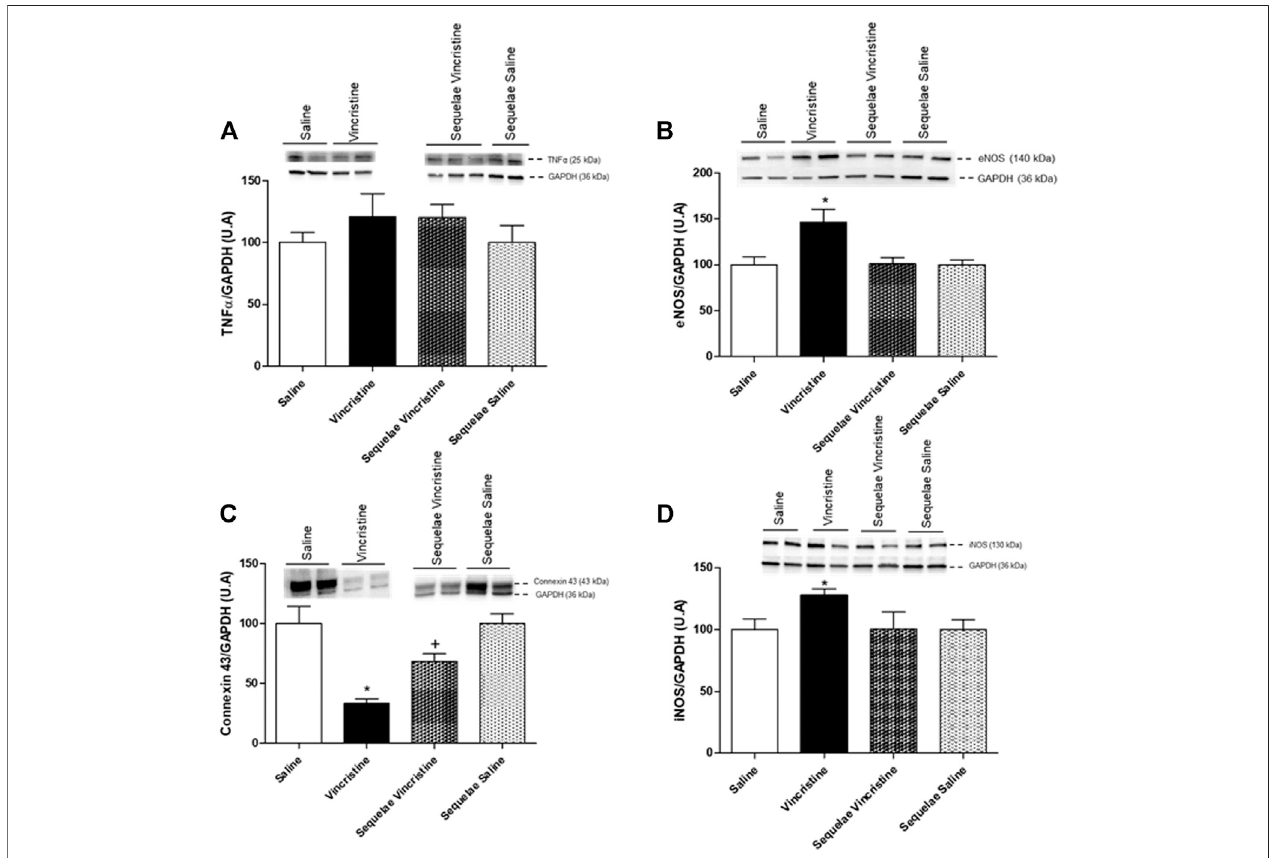
FIGURE 8 | Effects of vincristine treatment and two-week suspension of the treatment (sequelae) on TNF α (A) , eNOS (B) , connexin 43 (C) , and iNOS (D) protein expression in the aorta. Representative western blots show bands during vincristine treatment and 2 weeks after treatment (sequelae). Densitometric evaluations of protein levels were obtained from 5 – 6 different animals. Data represent the mean ± SEM. Saline vs. vincristine (* p < 0.05), sequelae saline vs. sequelae vincristine ( + p < 0.05).